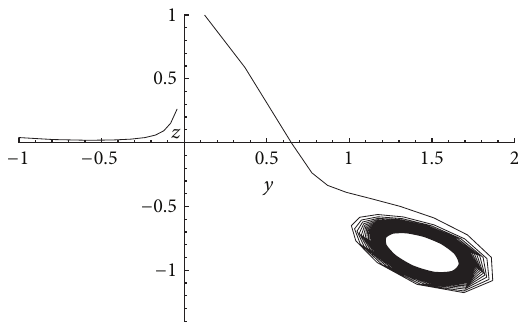
Figure 7: Lyapunov exponent- 𝛼 1 .